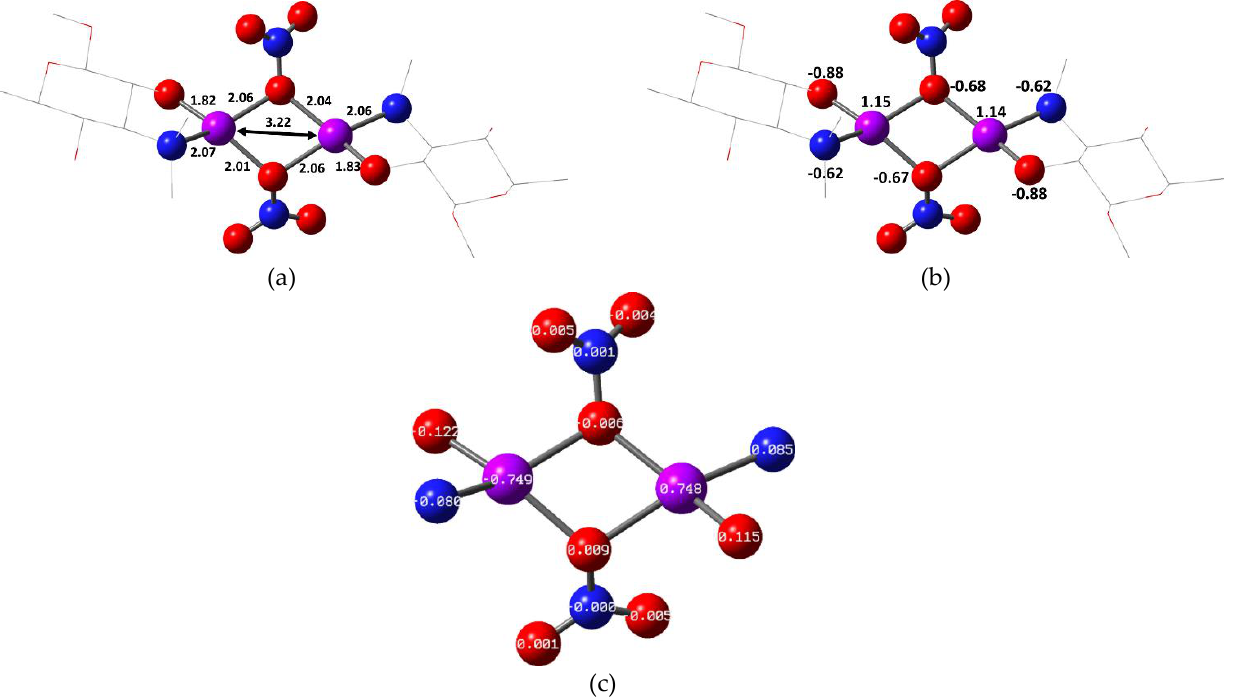
Figure 10. Optimized structure of the singlet open-shell blue mycaminosate complex 4 ( BHandHLYP ) with ( a ) structural parameters, ( b ) NBO charges and ( c ) spin density. Hydrogens are omitted for clarity. Colour code: C—grey, O—red, N—blue, Cu—magenta.